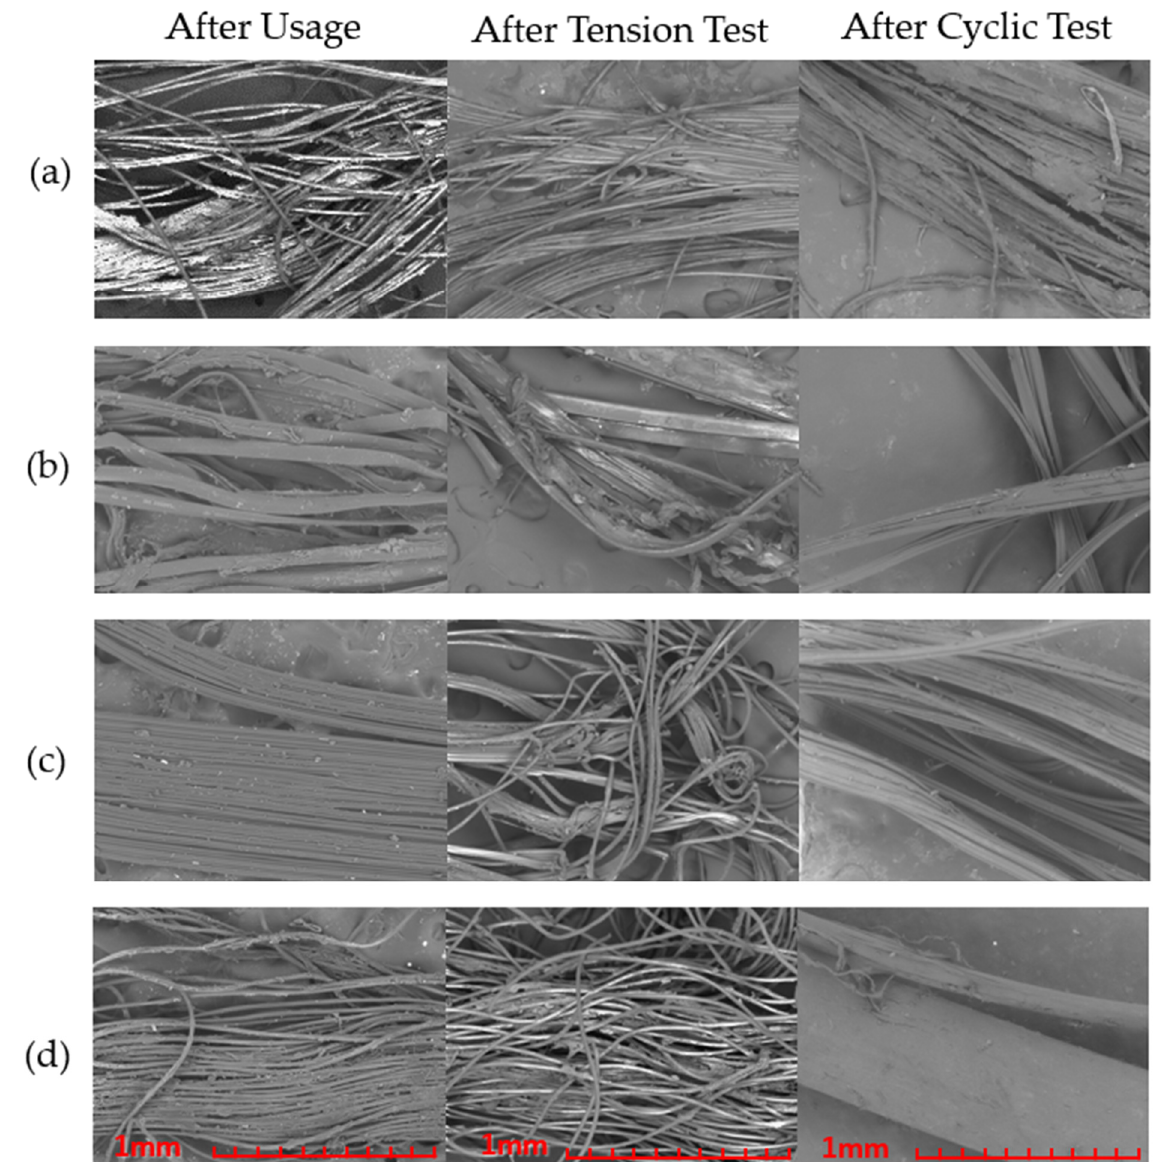
Figure 7. SEM images of floss defects of Lacalut ( a ), Oral B Essential ( b ), Oral B Satin ( c ), and Sensodyne ( d ) at an ×100 magnification.